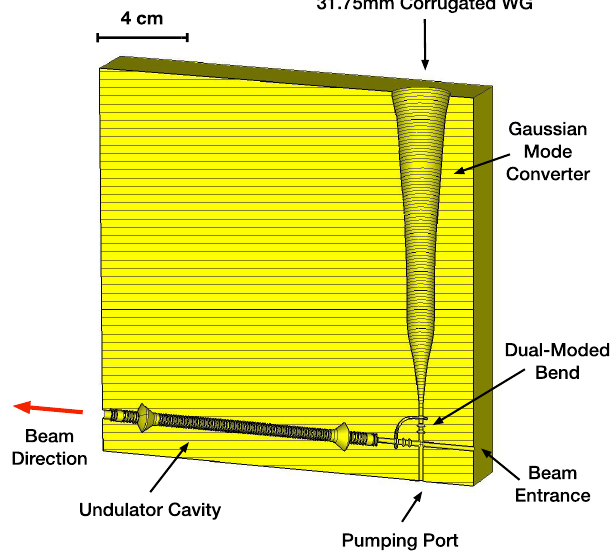
FIG. 1. Millimeter-wave undulator with coupling system cross section, adapted from Toufexis et al.